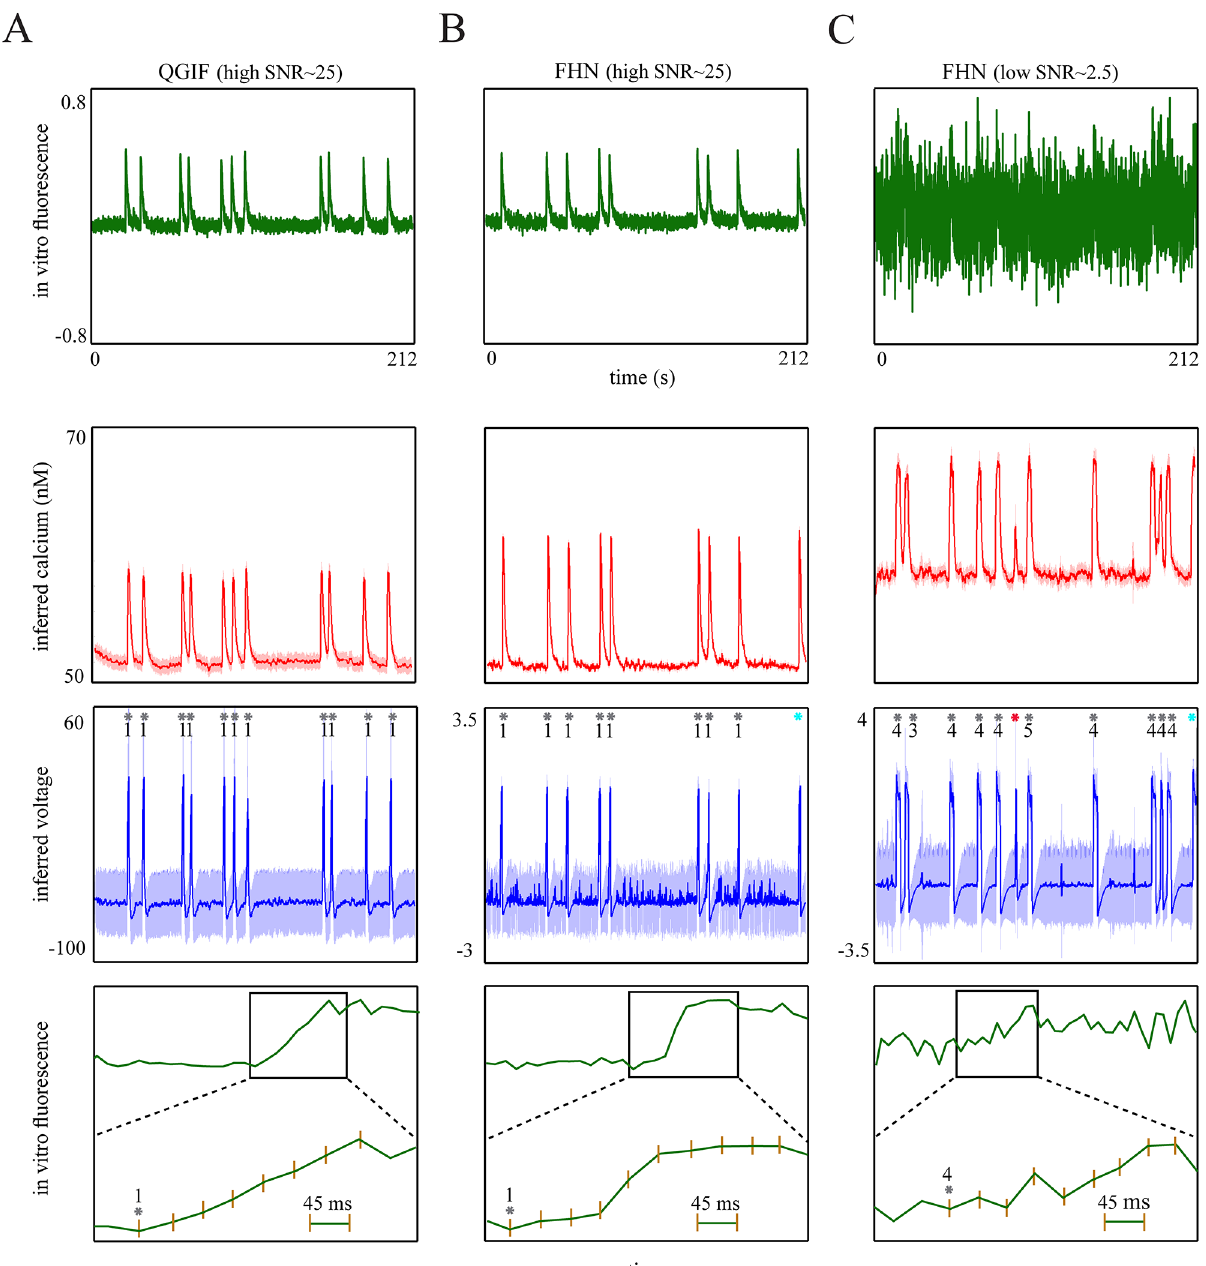
Fig 7. Results of the proposed approach for in vitro fluorescence traces with slowly rising transients (around 400 ms). ( A ): QGIF model, ( B ): FHN model with high SNR, ( C) FHN model with low SNR. First row ( A - C ): The in vitro fluorescence traces containing transients with relatively variable and slow rise times, mediated by spontaneous GDPs. The low SNR trace in C was generated by contaminating the in vitro trace by background noise. Second row ( A - C ): Inferred non-saturating [Ca 2+ ] kinetics, Third row ( A - C ): Inferred membrane potentials, where the onset times of GDP-mediated events (single spike or burst) determined by electrophysiological recordings (grey stars) and inferred spikes are highly concurrent. The two light blue stars indicate that there was no recorded transmembrane current available for the observed events in the fluorescence trace(s). Note that for a GDP-mediated burst event the onset time refers to the occurrence of its first spike. Fourth row ( A - C ): Zoom into the slow rise time of the first fluorescence transient in the traces shown in the first row. The numbers and stars indicate the veridical spike count and the onset time of each GDP. The rise time from GDP onsets to the fluorescence transient peaks was around 300 – 450 ms . The decay kinetics of the transients was lasting around 3.5 – 4.5